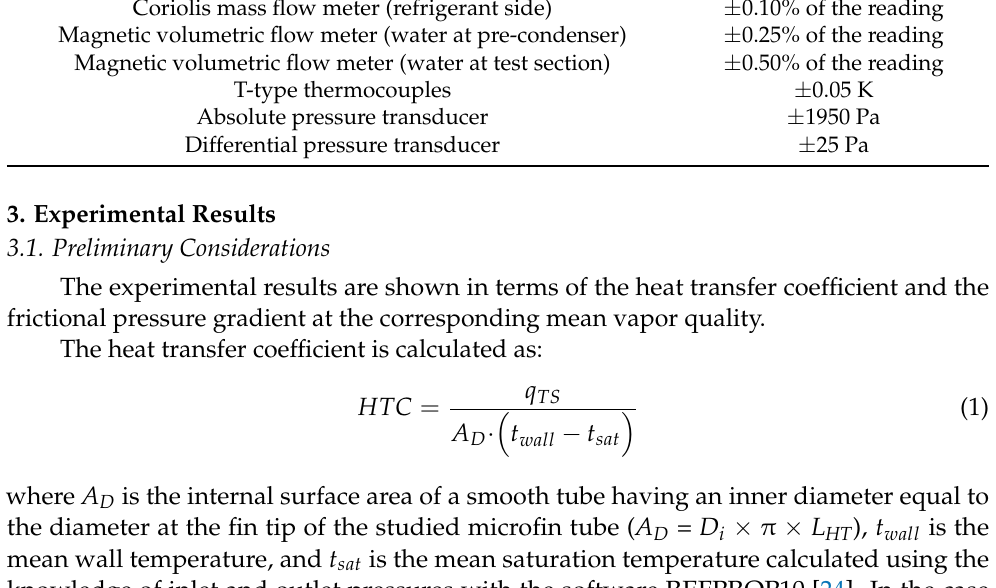
Table 1. Accuracy of the implemented instruments.